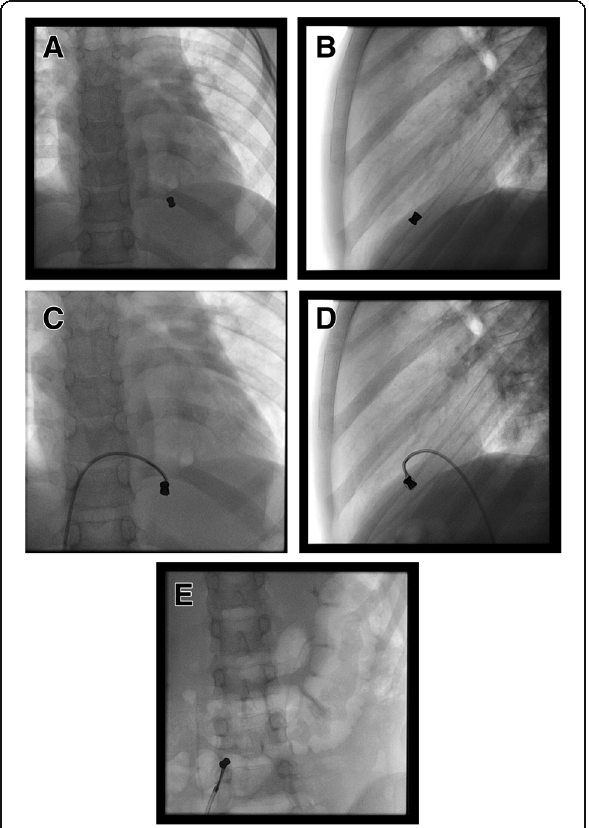
Fig. 3 a One air pellet in the right ventricle (antero-posterior view). b Air pellet in the right ventricle lateral view. c The Goose Neck Snare catching the pellet (AP view). d Snare catching the pellet (lateral view). e Air pellet caught by the snare and pulled down